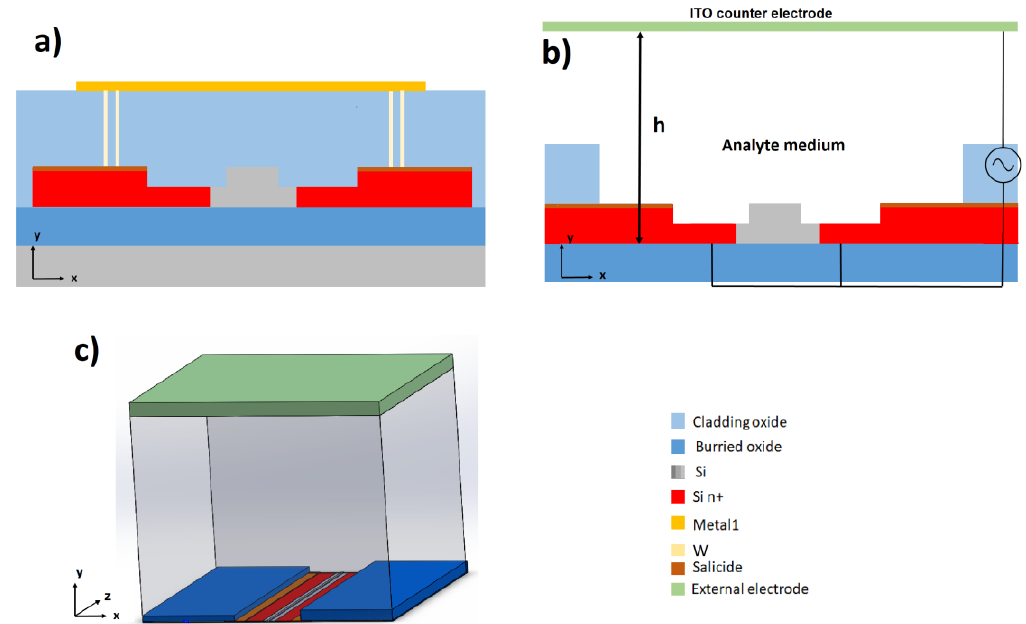
Figure 3. ( a ) Contacting the silicon waveguide: Cross-section of the silicon waveguide (xy plane) used for the 3D electrode geometry. The red areas represent highly-doped silicon that is contacted via a channel from the metal 1 layers. Most of the waveguide is covered by an SiO 2 layer to protect it from the outside and prevent losses. ( b ) In the sensing areas, the SiO 2 is etched off, to allow exposure of the waveguide to the analyte medium. The doped area on the waveguide functions as a dielectrophoresis (DEP) electrode, whereas the counter electrode is placed on top of a microfluidic channel with the distance h in the y-direction to the waveguide. ( c ) 3D view of the sensor region.